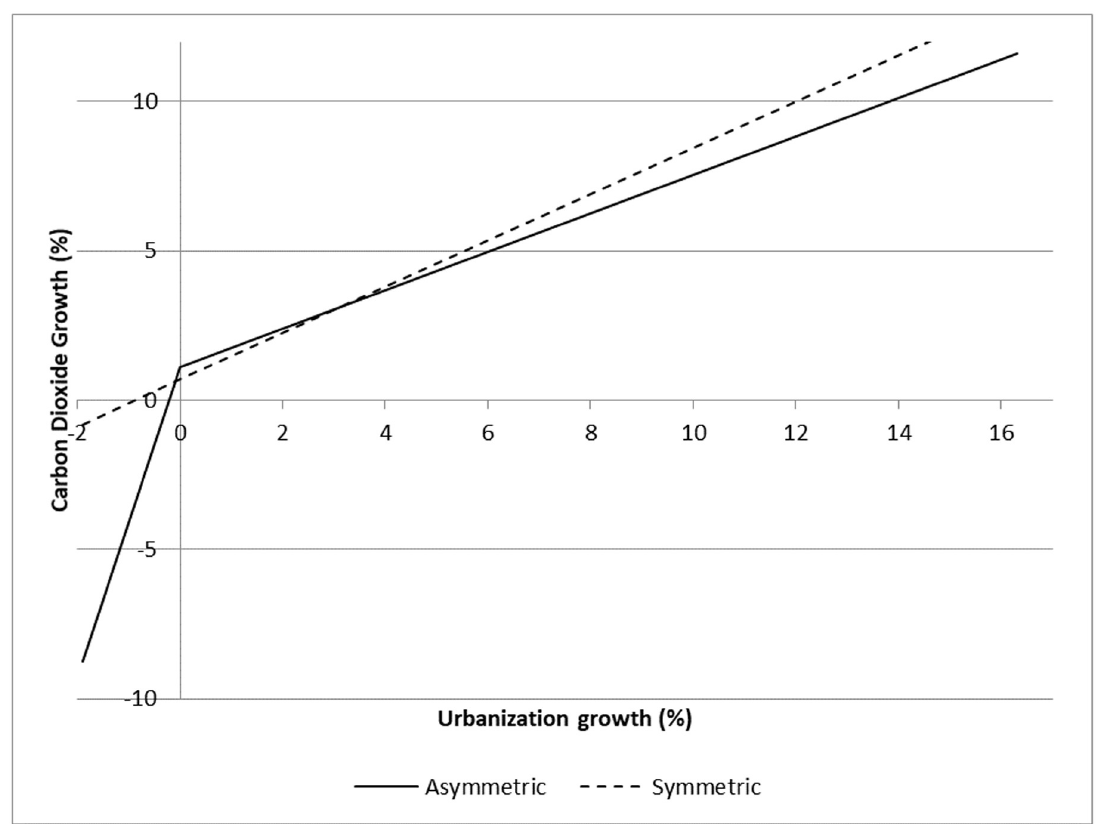
Fig 1. Effect of change in urbanization on CO 2 emissions from asymmetric and symmetric models. Calculated based on the urbanization coefficients presented in Table 1 with the y-intercept calculated based on averaging all of the year-dummies.